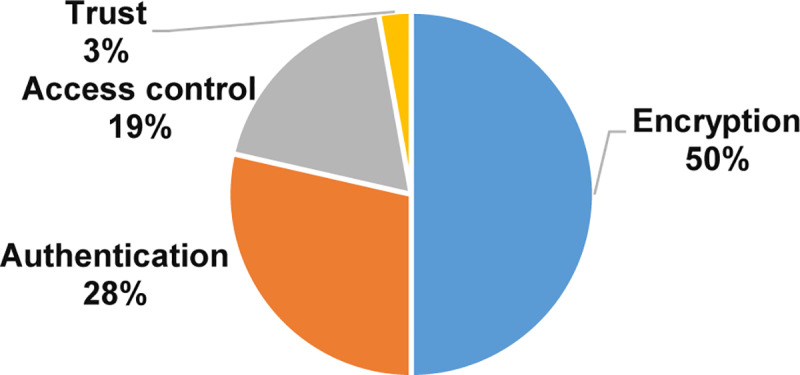
Privacy solutions.